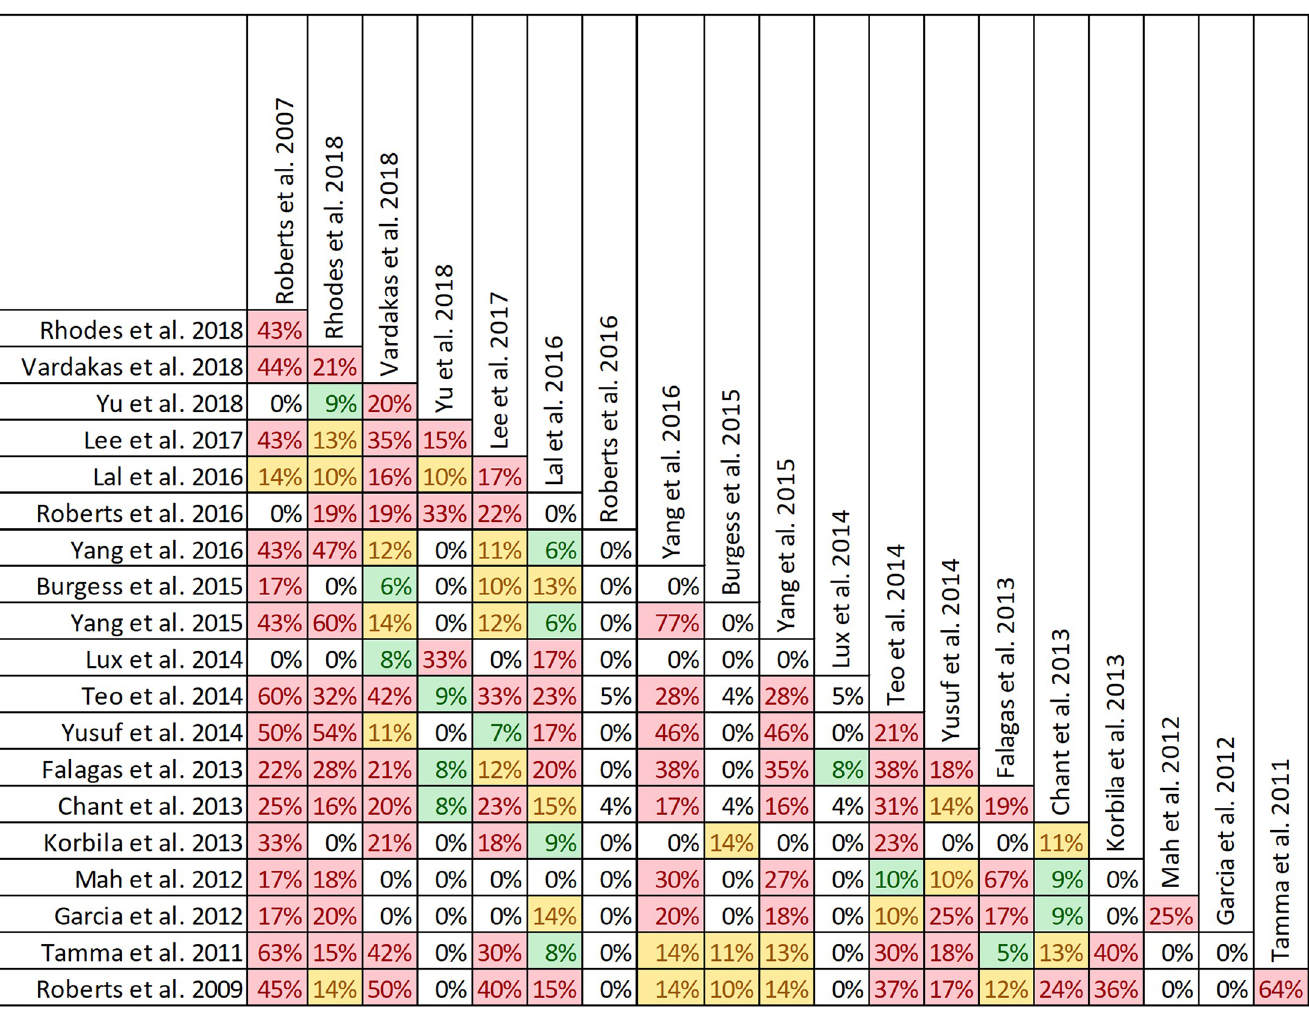
Fig 5. Pairwise CCA for reviews reporting mortality of prolonged vs. intermittent infusions of beta-lactams. Colors indicate degree of overlap, as calculated with CCA, for visual clarity. White = � 5%, green 5.1–9.9%, yellow 10–14.9%, red � 15%.